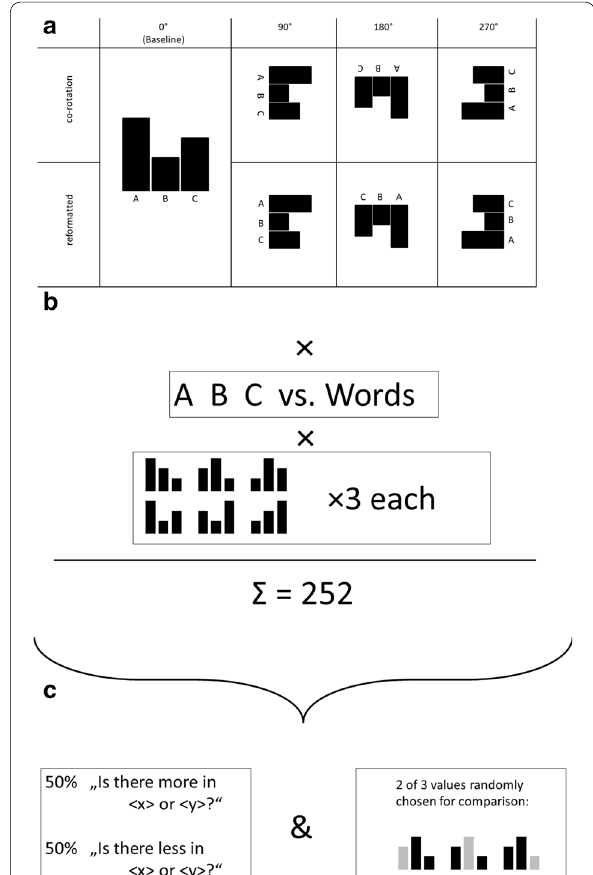
Fig. 2 Illustration of the design of Experiment 1. a The baseline condition is an unrotated bar graph labeled either with words or letters. Relative to this baseline, we investigated three different angular rotations (90°, 180°, and 270°) and two different categories of labels (co-rotating vs. reformatted). b We manipulated the labels of the bar graph (words vs. letters). There were six different arrangements of the bars (each repeated three times), resulting in a total of 252 trials. c In one half of the trials (selected randomly), the participants had to indicate the smaller bar in comparison. In the other half, the participants indicated the larger bar. The two bars involved in the comparison were selected randomly. Each participant received a unique set of